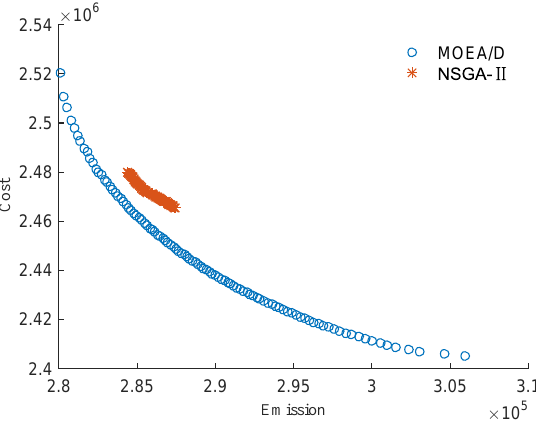
Figure 4. PFs obtained by of different methods.